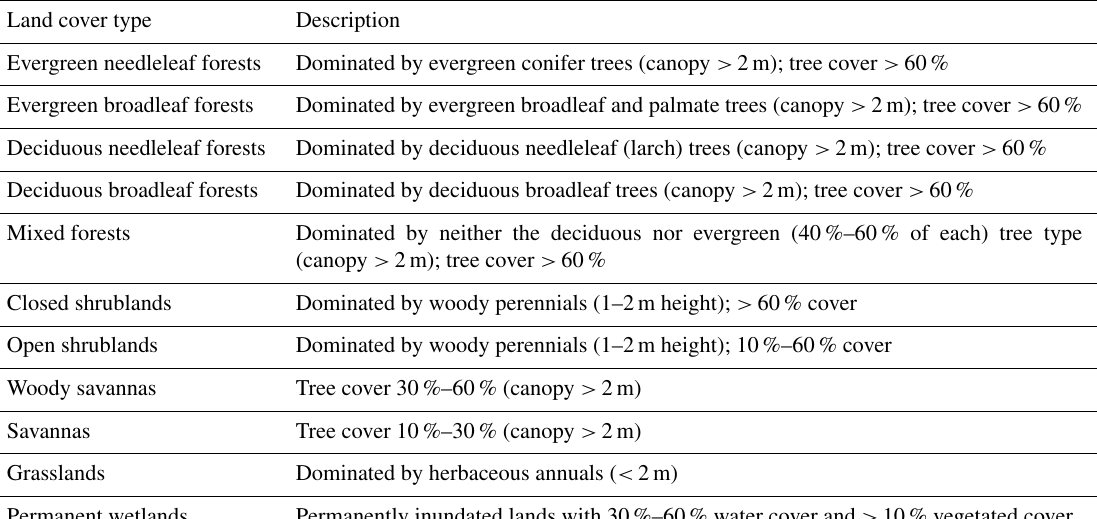
Table 3. Definitions of the land cover types detected in this study, from the MODIS International Geosphere–Biosphere Programme (IGBP) classification